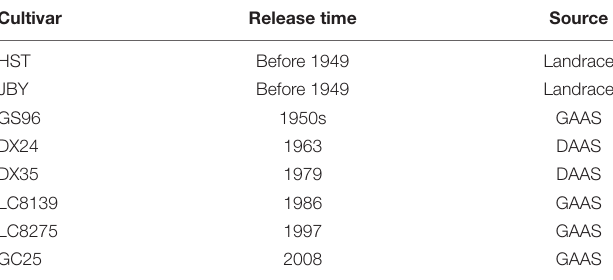
TABLE 1 | Name and source of cultivars used in the experiment.